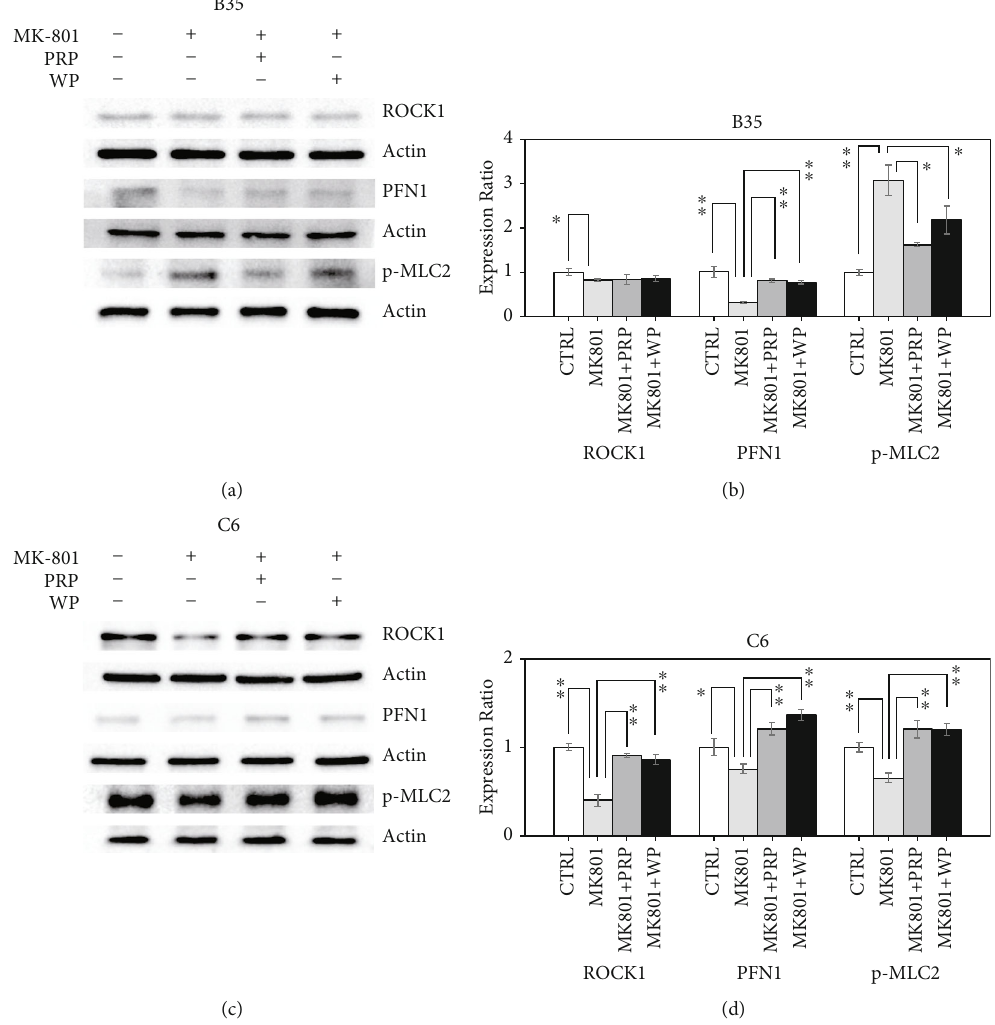
Figure 3: PRP and WP regulate MK-801-induced ROCK1, PFN1, and p-MLC2 regulation. Western blotting revealed the expression changes of ROCK1, PFN1, and p-MLC2 induced by PRP/WP in (a) B35 and (c) C6 cells treated with MK-801. The protein expression was quanti fi ed by using ImageJ software. Beta-actin was used as a normalization control to calculate relative expression of examined target. The bar chart was constructed according to the data of three independent western blot experiments that analyzed three di ff erent batches of protein extracts of drug-treated (b) B35 and (d) C6 cells. The data was analyzed by using Student ’ s t -test ( ∗ p value < 0.05; ∗∗ p value < 0.01)